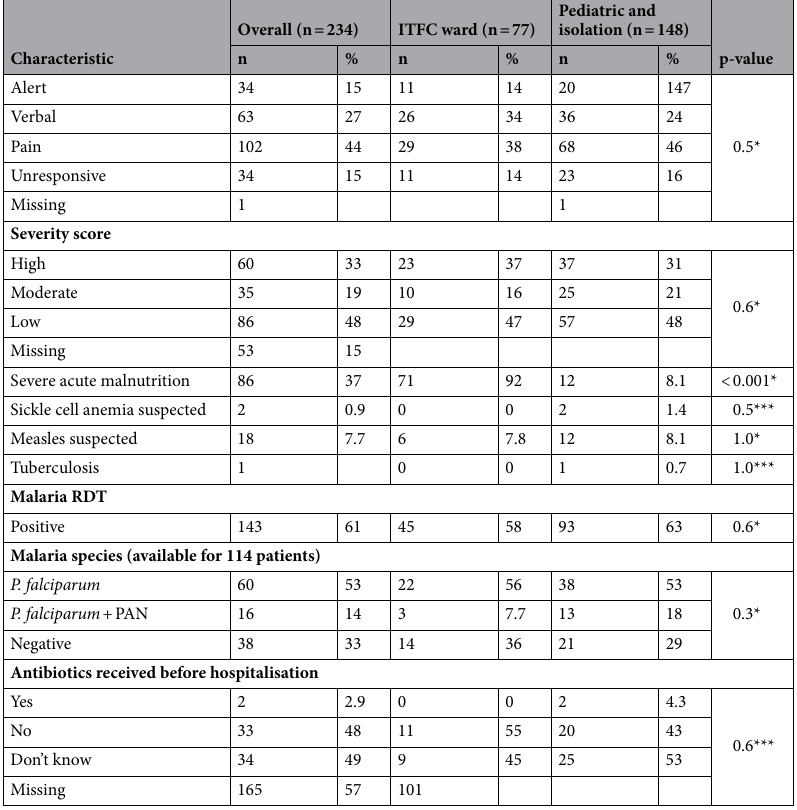
Table 2. Clinical characteristics at admission of pediatric patients with severe sepsis at AGH overall and by ward of admission (ITFC or pediatric/isolation ward), November 2018–August 2020. ¥ SD standard deviation, ¥¥ IQR inter quartile range, *Chi-square test of independence, **Wilcoxon rank-sum test, ***Characteristic Fisher’s exact